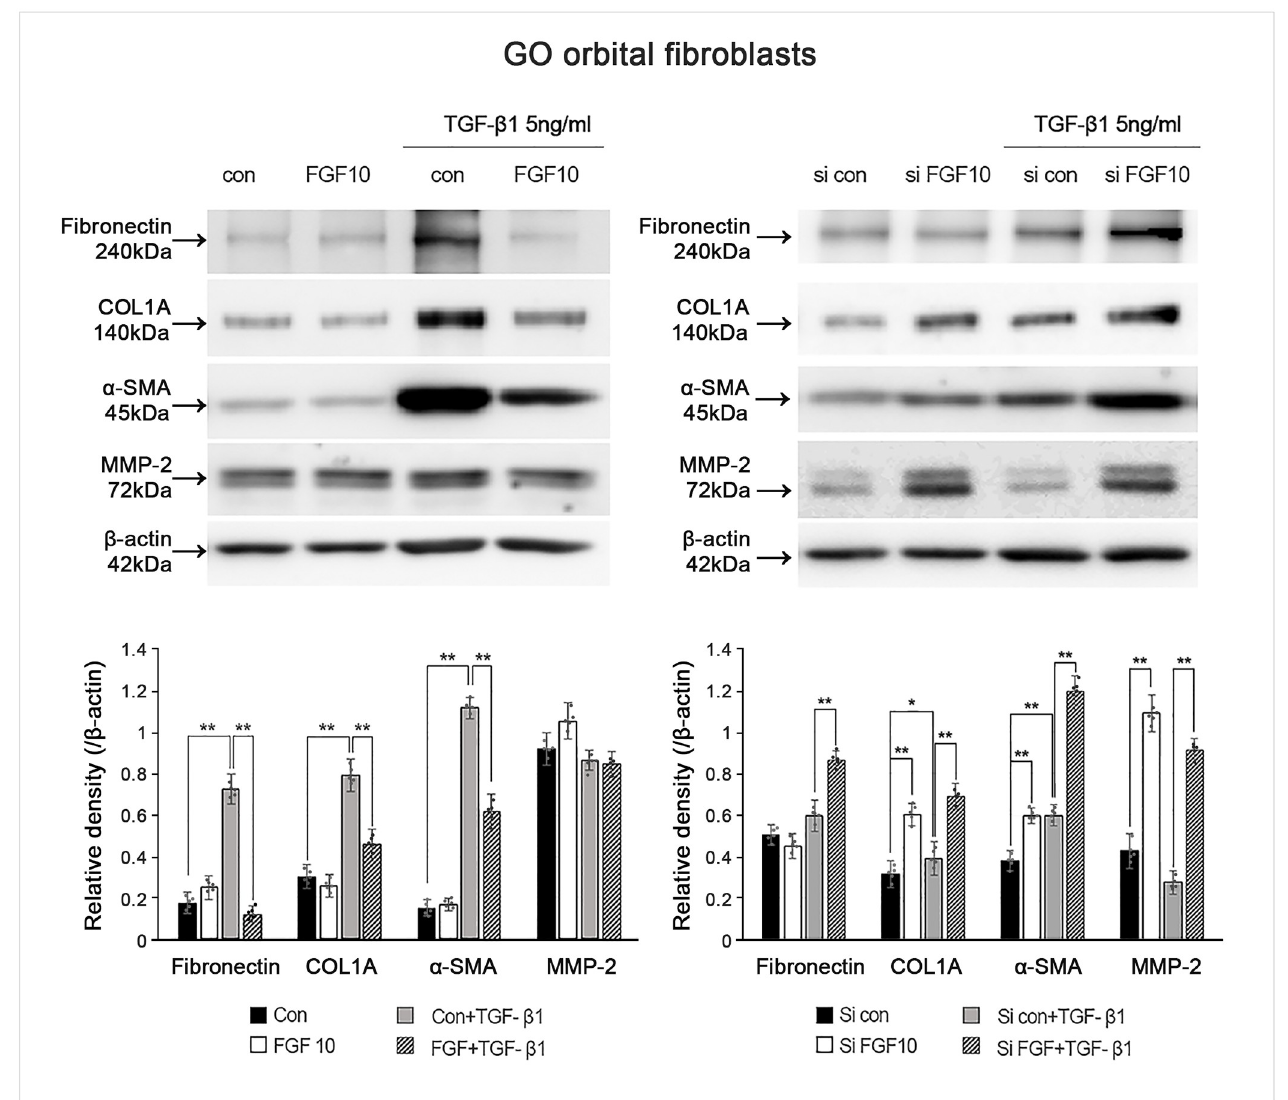
Fig 5. Effect of upregulation of fibroblast growth factor 10 (FGF10) using recombinant human (rh) FGF10 or blockage of FGF10 by small interfering (si) FGF10 transfection on transforming growth factor (TGF)- β 1 induced fibrosis-related protein expression. The rhFGF10 suppressed the TGF- β 1 induced fibronectin, collagen I α (COL1A), and α -smooth muscle actin ( α -SMA) expression in Graves 0 orbitopathy (GO) orbital fibroblasts (OFs). Knockdown of FGF10 induced the increase of TGF- β 1 induced fibronectin, COL1A, and α -SMA expression in GO OFs. Bar graphs show the relative density of each protein normalized to the level of β -actin and are represented as mean ± standard deviation. Experiments were performed in at least three cells cultured from different strains. � p < 0.05, �� p <